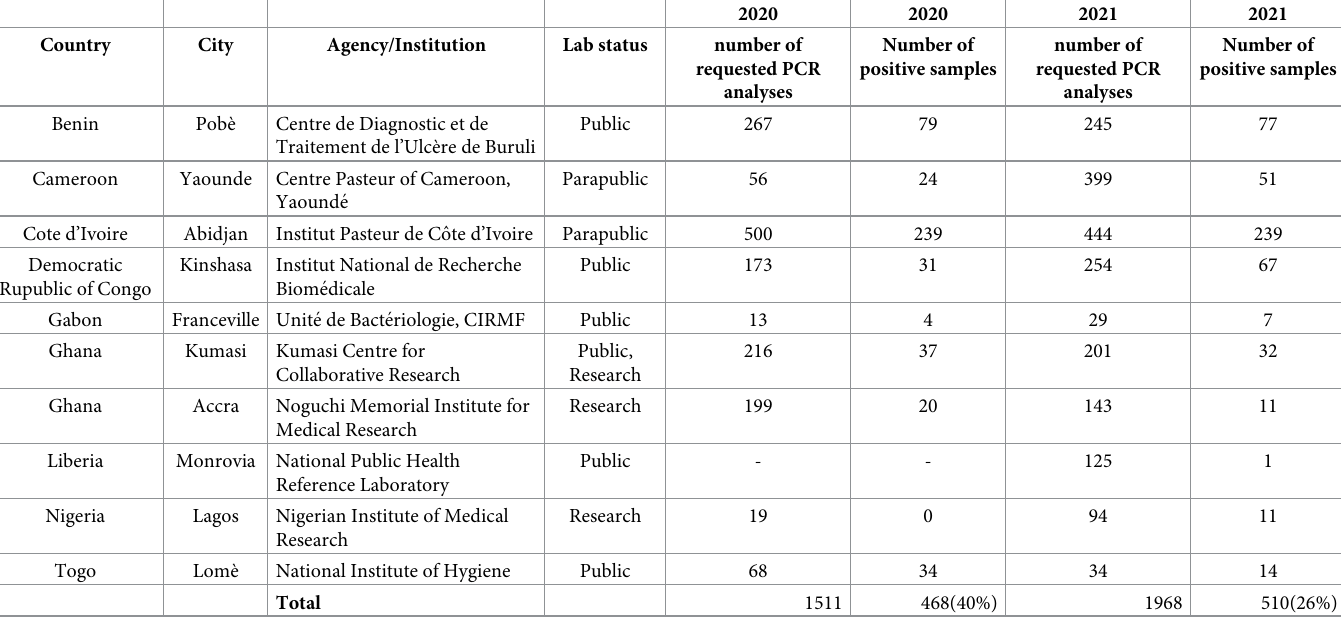
Table 4. Laboratories from 9 African countries and activities in 2020 and